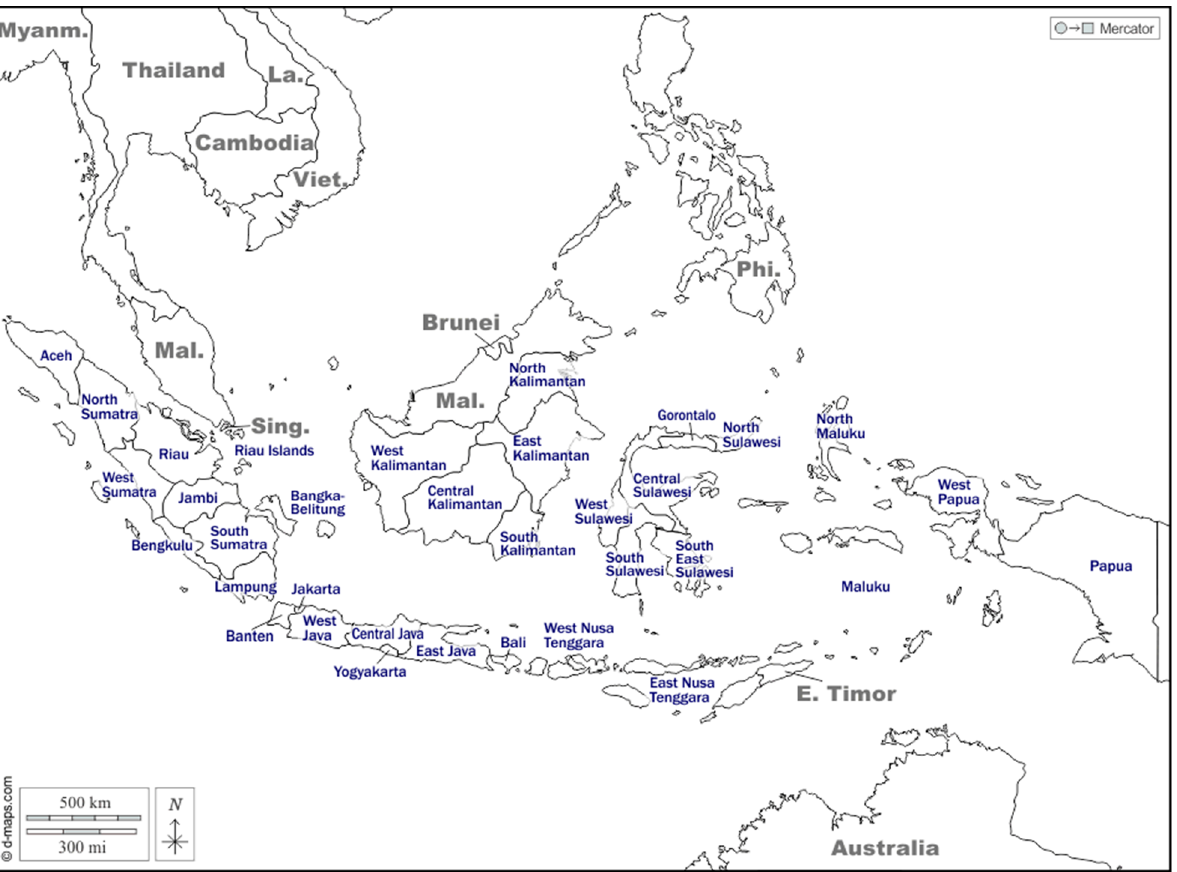
Figure 1. Indonesian map along with selected research locations (free to use from d-maps.com (2022) with certain conditions).